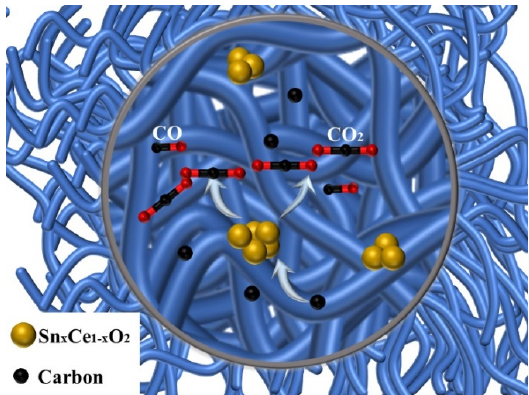
Figure 1. Schematic diagram of the soot reaction mechanism in a Sn x Ce 1-x O 2 fiber catalyst.